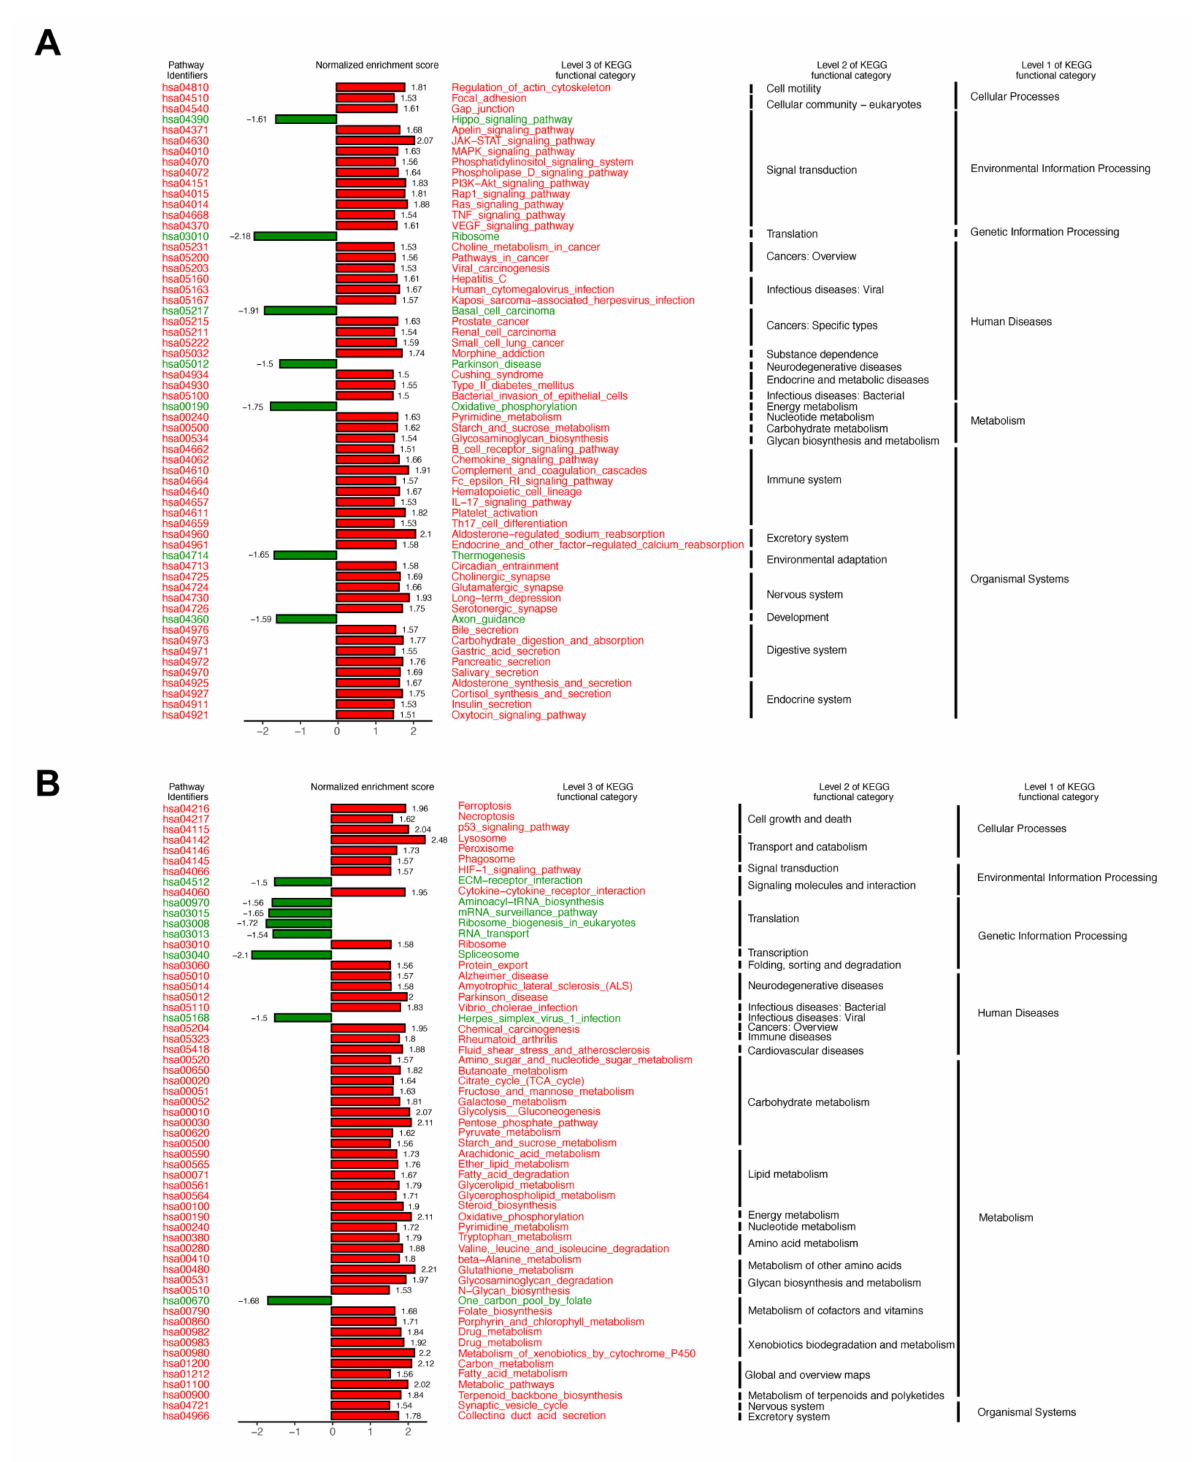
Figure 5. Kyoto Encyclopedia of Genes and Genomes (KEGG) pathway enrichment analysis of RNA sequencing: Signif- icantly different functional KEGG categories (NES > 1.5 or < − 1.5 and p < 0.05) were shown. ( A ) Results of low fluence (10 mW/cm 2 × 12 min) versus the non-irradiated control group. ( B ) Results of high fluence (40 mW/cm 2 × 12 min) versus the non-irradiated control group. NES: normalized enrichment